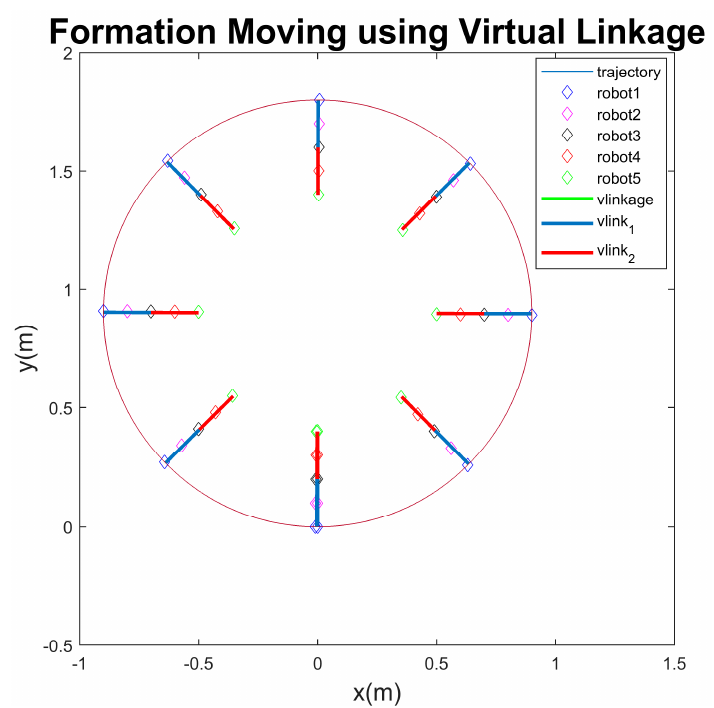
Figure 14. Snapshot of the formation moving of five agents.